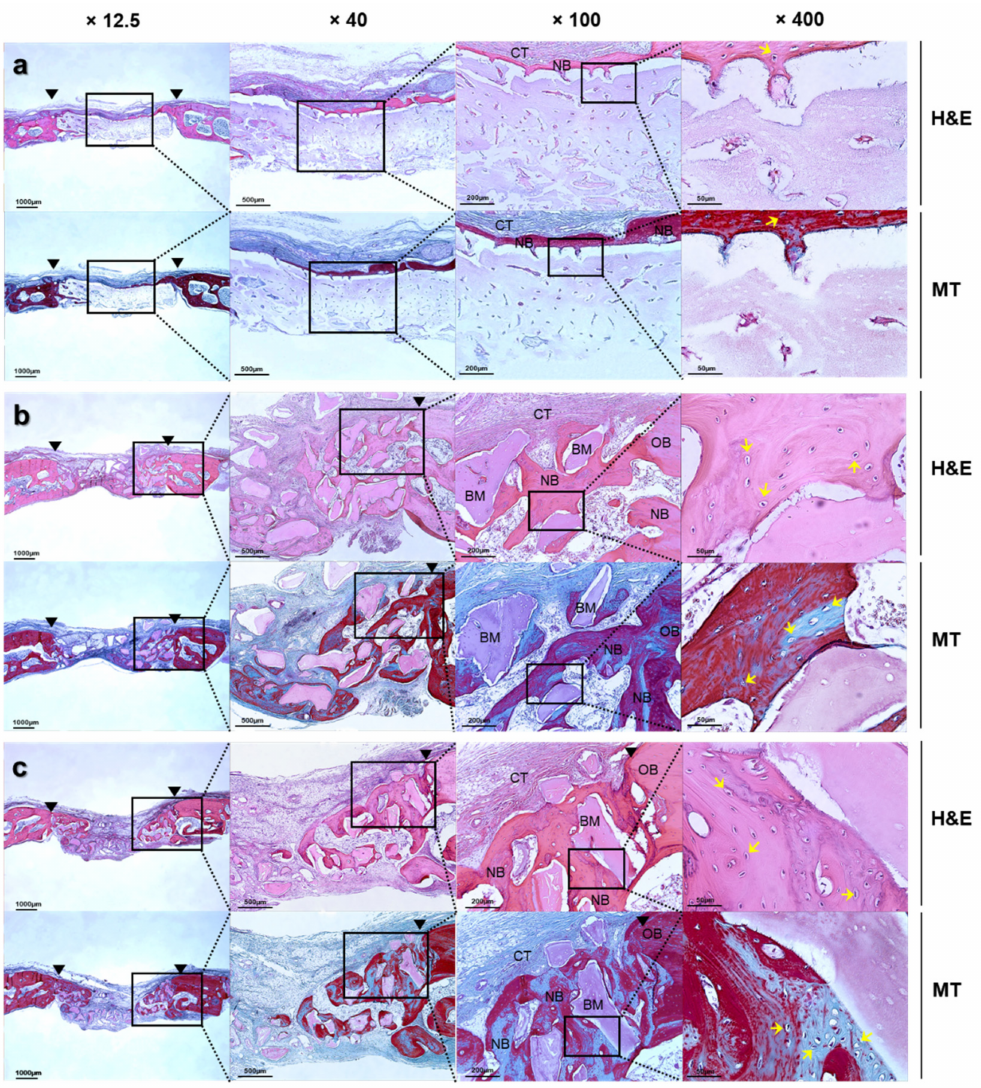
Figure 12. Histologic sections of calvaria defects from rabbits at 8 weeks after surgery. ( a ) Control, ( b ) Bo-Hy, and ( c ) Po-Hy (black arrow: defect border margin, yellow arrow: osteocyte, BM: bone graft material, NB: new bone, OB: old bone, CT: connective tissue, H&E: Hematoxylin & Eosin, MT: Masson’s